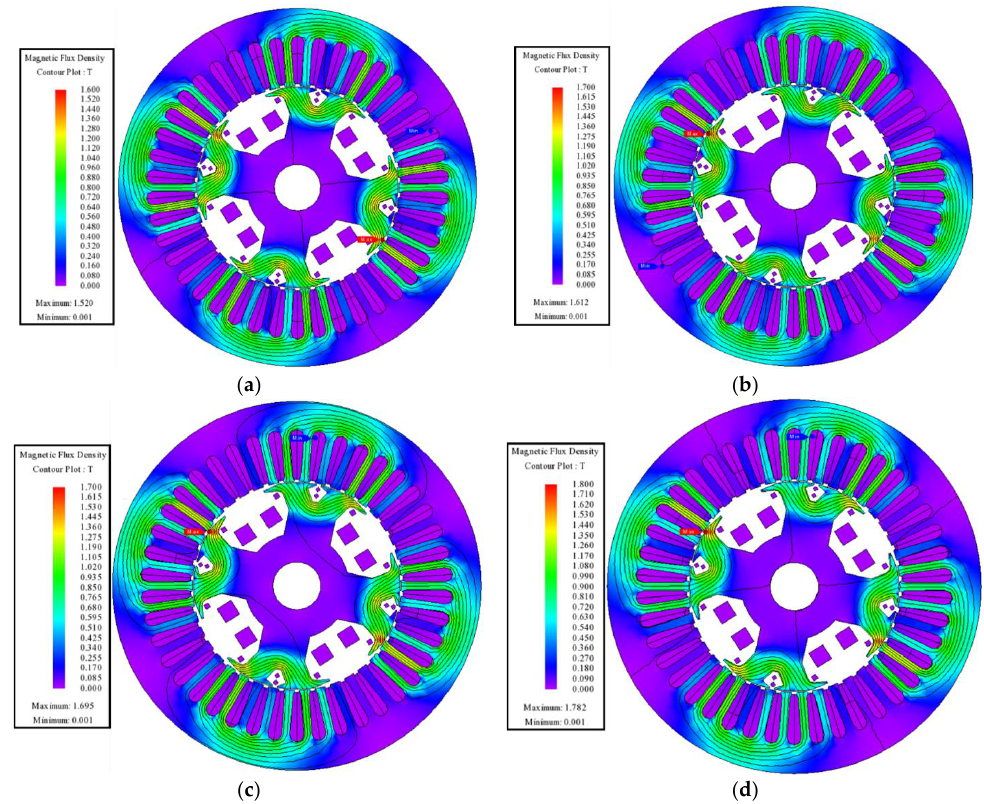
Figure 8. Magnetic field density plots of the machine having ( a ) 0.6 A, ( b ) 1.2 A, ( c ) 1.8 A, and ( d ) 2.4 A dc offset for each phase of armature currents.